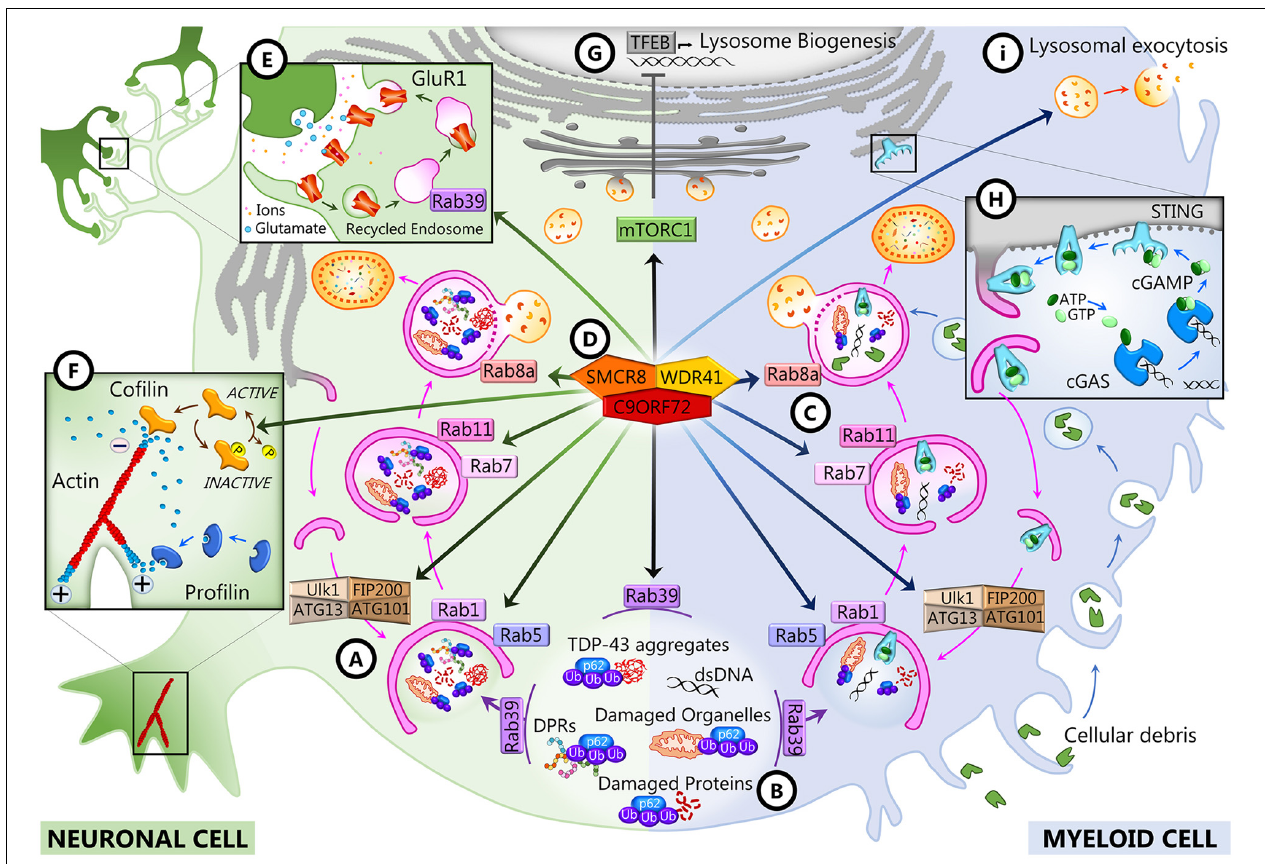
FIGURE 2 | C9ORF72 functions in neurons and myeloid cells. In both cell types, C9ORF72 regulates autophagy and vesicular trafficking at different levels: the initiation of autophagy (A) , the recruitment of substrates for autophagy degradation (B) , and autophagosome maturation and closure (C) . These and other functions depend on the interaction of C9ORF72 with its partners SMCR8 and WDR1 inside a GTPase-interacting complex (D) , which is also responsible for interfering with mTORC1 signaling (G) . In neurons, C9ORF72 regulates actin dynamics (F) and endosomal recycling of GluR1 at the synapse (E) . In myeloid cells, C9ORF72 modulates the STING pathway (H) and lysosomal exocytosis (I)